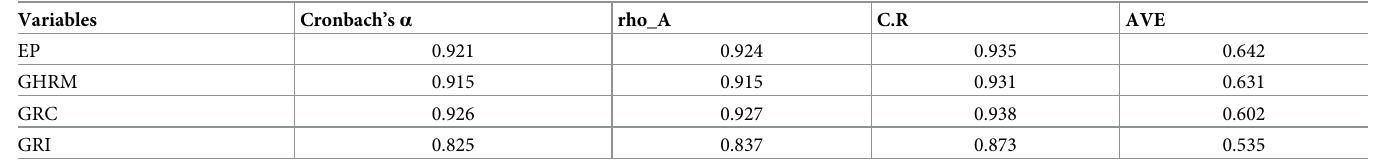
Table 2. Constructs’ reliability and convergent